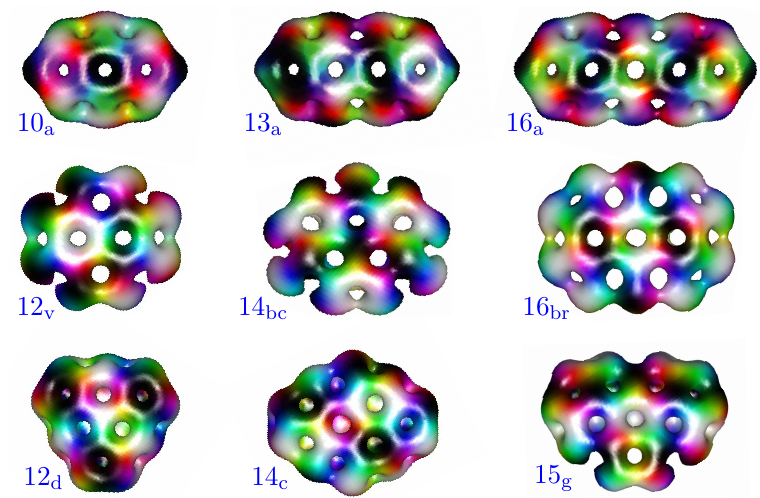
Figure 7. Graphene Skyrmions.